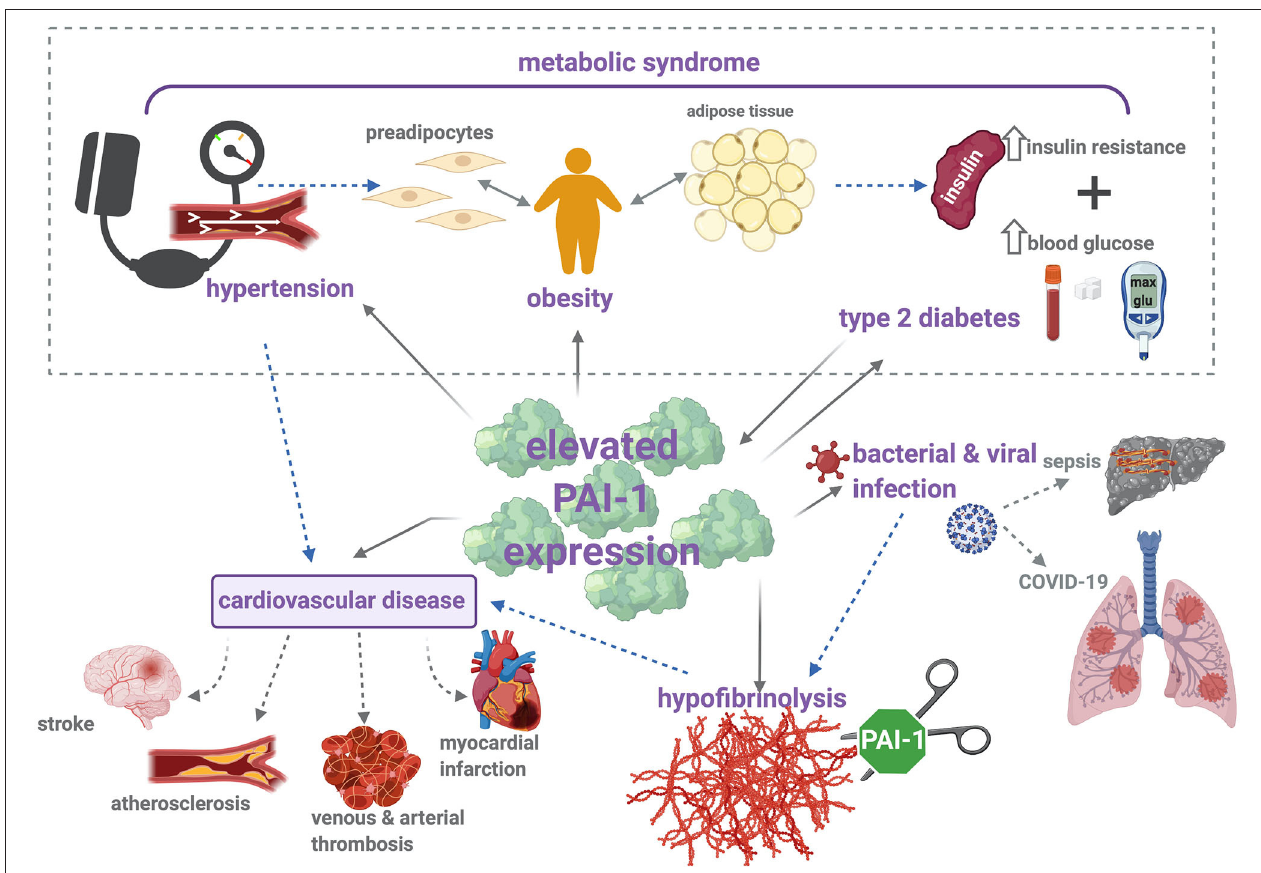
FIGURE 2 | PAI-1 modulates thrombosis and inflammation via multiple pathophysiological mechanisms. Metabolic syndrome is characterized by increased insulin resistance, obesity, and hypertension, which contribute to elevated risk of cardiovascular disease (CVD). Increased levels of PAI-1 antigen and activity are positively associated with hypertension, obesity, type 2 diabetes (T2DM), and CVD. Briefly, elevated levels of PAI-1 antigen and activity occur in obesity, which is a known risk factor for CVD and T2DM. Strong correlations between increased PAI-1 and development of T2DM have been identified, including increased insulin resistance and impaired glucose tolerance. Conversely, insulin and glucose can stimulate PAI-1 secretion from adipose tissue. Elevated levels of PAI-1 attenuate plasmin formation and downregulate fibrin degradation. This hypofibrinolytic state provokes thromboembolic complications, including stroke, atherosclerosis, myocardial infarction, and venous and arterial thrombosis. Hypofibrinolysis and elevated PAI-1 levels have been associated with bacterial and viral infections, including sepsis and COVID-19. Sepsis is characterized by the development of disseminated intravascular coagulation (DIC), a major contributor to resulting organ failure. In COVID-19 patients, disruption between coagulation and fibrinolysis leads to fibrin deposits in the lung parenchyma and thrombosis. Solid arrows represent (patho)physiological processes that arise as a result of increased PAI-1 levels, and dotted arrows illustrate the links between each of these individual